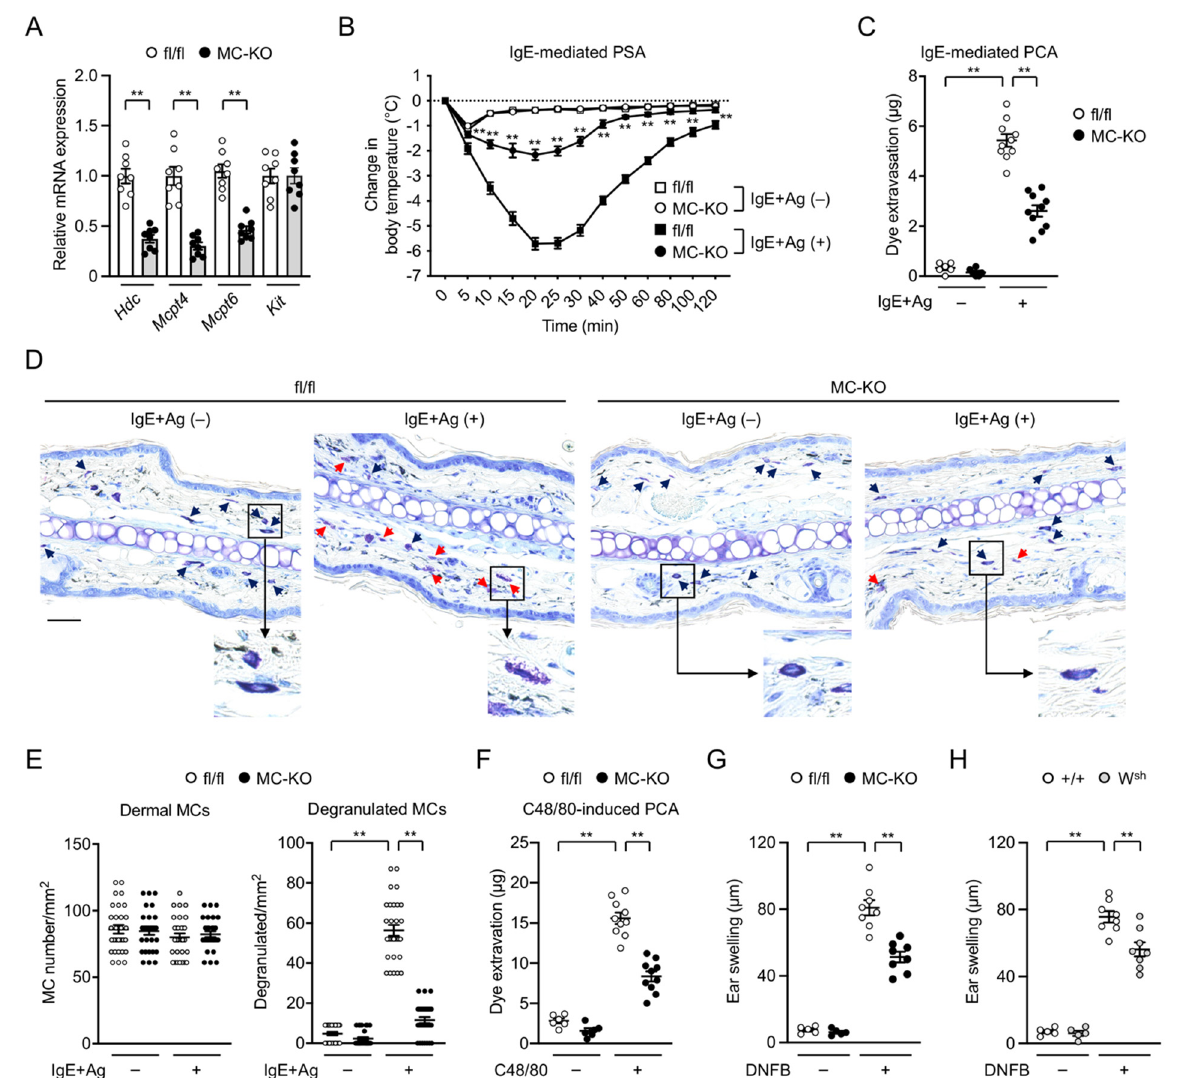
Figure 3. Impaired anaphylaxis and irritant dermatitis in MC-specific Pla2g3 -deficient mice. ( A ) Expression of Hdc , Mcpt4 , Mcpt6 , and Kit in ear skin of Pla2g3 fl/fl (fl/fl) and Pla2g3 fl/fl Mcpt5 - Cre (MC-KO) mice (n = 8). Gapdh was used as a reference gene for normalization. Expression levels of individual genes in fl/fl were regarded as 1. ( B ) IgE-mediated PSA. Changes in rectal temperatures over time after challenge with vehicle (IgE + Ag ( − ), n = 5) or DNP-HSA (IgE + Ag (+), n = 8) in Pla2g3 fl/fl (squares) and Pla2g3 fl/fl Mcpt5 - Cre (circles) mice. ** , p < 0.01 for Pla2g3 fl/fl Mcpt5 - Cre mice versus Pla2g3 fl/fl mice. ( C ) IgE-mediated PCA. Dye extravasation 30 min after challenge with vehicle (IgE + Ag ( − ), n = 5) or DNP-HSA (IgE + Ag (+), n = 10) in Pla2g3 fl/fl and Pla2g3 fl/fl Mcpt5 - Cre mice. ( D ) Photomicrographs of representative toluidine blue-stained sections of ear pinnae from Pla2g3 fl/fl and Pla2g3 fl/fl Mcpt5 - Cre mice 2 min after vehicle or Ag challenge. Insets show higher magnifi- cation of each boxed area. Arrowheads indicate MCs (resting, black arrows; degranulated, red arrows). Scale bar, 25 µm. ( E ) The number of dermal MCs/mm 2 after vehicle or Ag challenge. Thirty views for each group (n = 5). ( F ) C48/80-induced PCA. Dye extravasation 30 min after administration with vehicle ( − , n = 5) or C48/80 (+, n = 10) in Pla2g3 fl/fl and Pla2g3 fl/fl M- cpt5 - Cre mice. ( G , H ) DNFB-induced ICD. Ear swelling after treatment for 4 h with vehicle ( − , n = 5) or DNFB (+, n = 8) in Pla2g3 fl/fl and Pla2g3 fl/fl Mcpt5 - Cre mice ( G ) or Kit W-sh (W sh ) and Kit +/+ (+/+) controls ( H ). Data, mean ± SEM. **, p < 0.01; ( A ) two-tailed Mann–Whitney test; ( B ) two-way and ( C , E – H ) one-way ANOVA. Data are pooled from 2 independent experi- ments, each of which gave similar results.